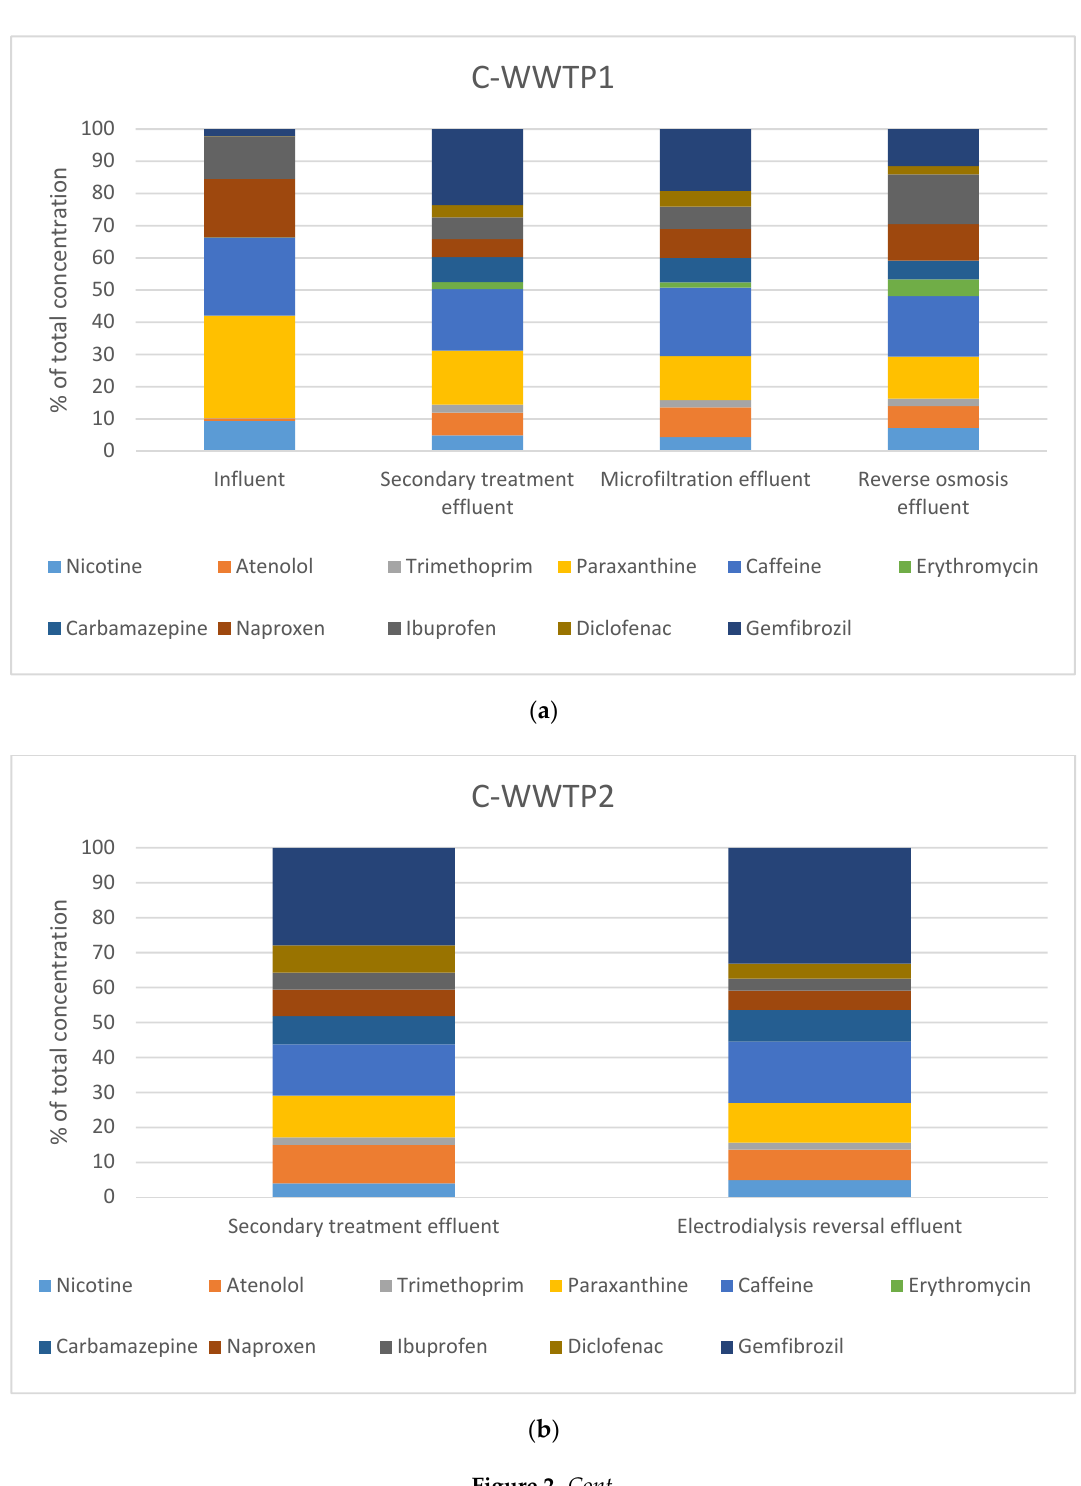
( c ) Figure 2. Distribution of pharmaceuticals from Table 1. ( a ) C-WWTP1, ( b ) C-WWTP2, ( c ) N-WWTP. 3.2. Removal of Target Pharmaceuticals As previously stated, pharmaceutical compounds have become a concerning group of emerging pollutants to the scientific community and their removal from wastewaters is essential to ensure the environmental quality of recipient ecosystems. Biologically-based WWTPs produce effluents that maintain water quality standards in order to reuse them or dispose into the environment at a reasonable cost, but these WWTPs have limited capability to remove pharmaceuticals [33]. For this